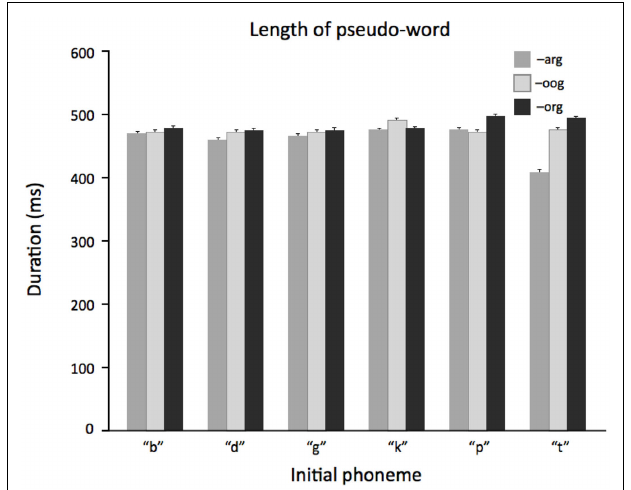
FIGURE 2 |The mean duration in milliseconds of the five recordings of each pseudo-word. Error bars are